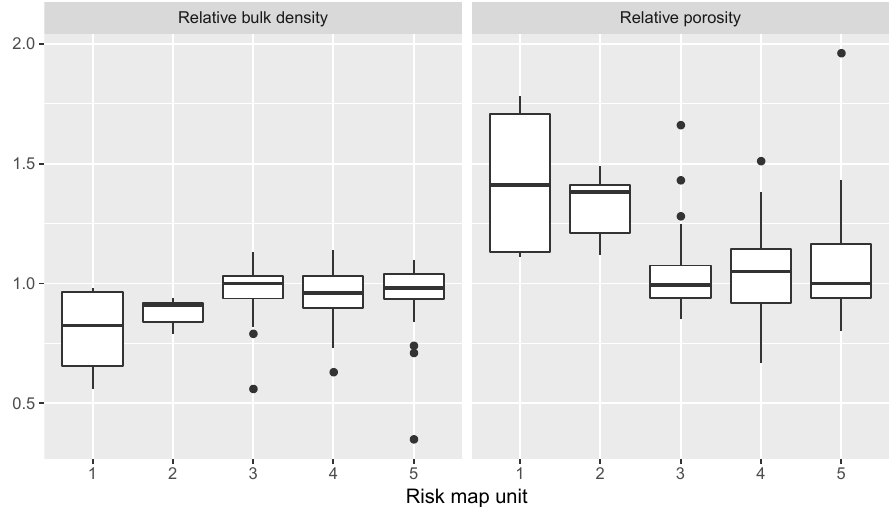
Figure 2. Box plots of relative bulk density and relative porosity per risk map unit (1: low risk; 5: high